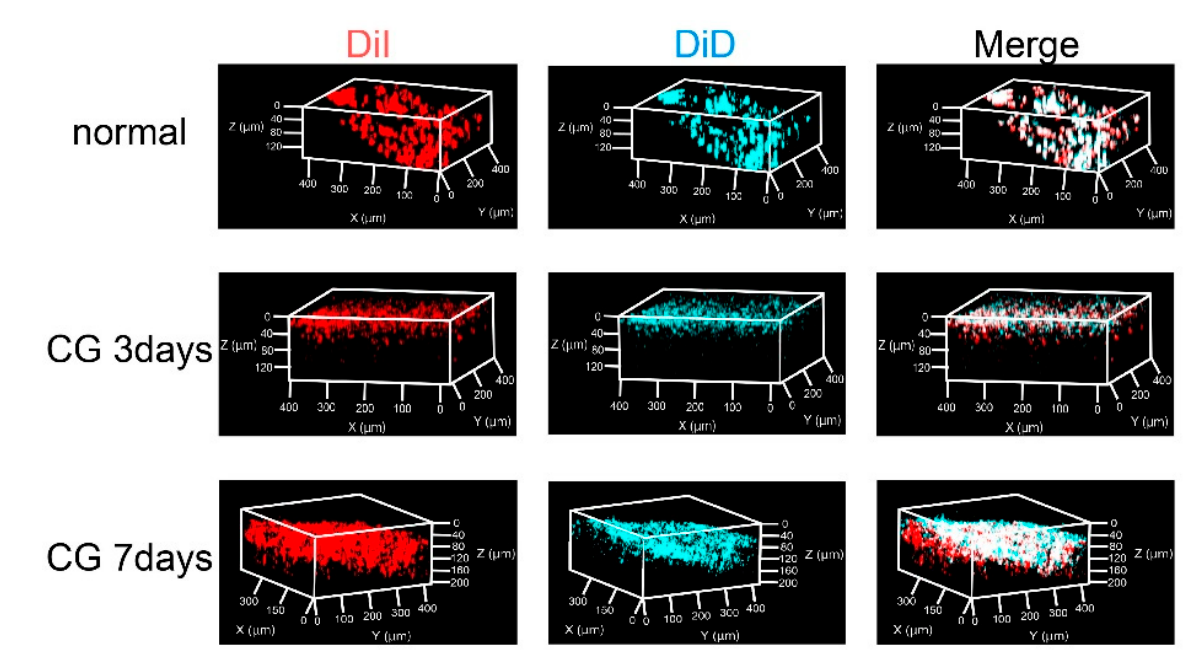
Figure 3. Evaluation of the migration of mesothelial cells in early-stage peritoneal fibrosis. Spatial distribution of mesothelial cells in the peritoneum after CG injection. DiI solution was intraperitoneally injected before CG treatment to label mesothelial cells that were originally located on the surface of the peritoneal wall. DiD solution was intraperitoneally injected before tissue clearing to label the surface of the peritoneum. Each specimen was observed with confocal laser scanning microscopy (CLMS) following to cleared with Sca l eSQ(0)